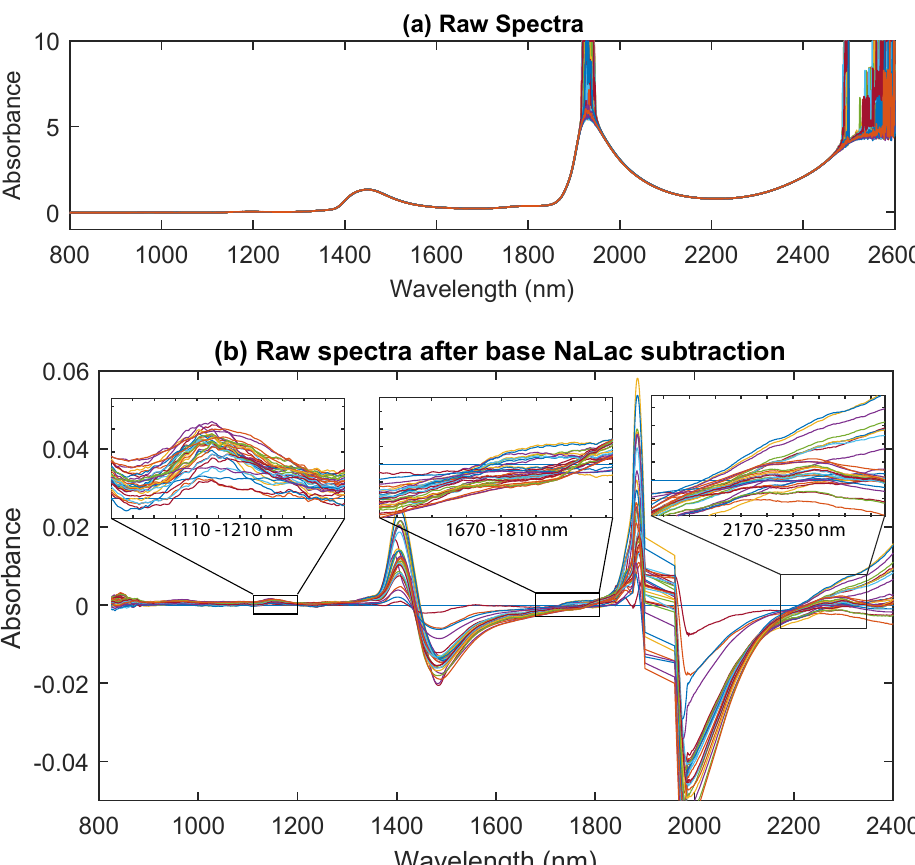
Figure 3. ( a ) The raw near-infrared (NIR) spectra of thirty-seven PBS samples and ( b ) the NIR spectra of samples after base lactate correction. Absorption peaks pertinent to NaLac can be seen in the regions between 1100 and 1210 nm, 1670 and 1810 nm, and 2170 and 23,500